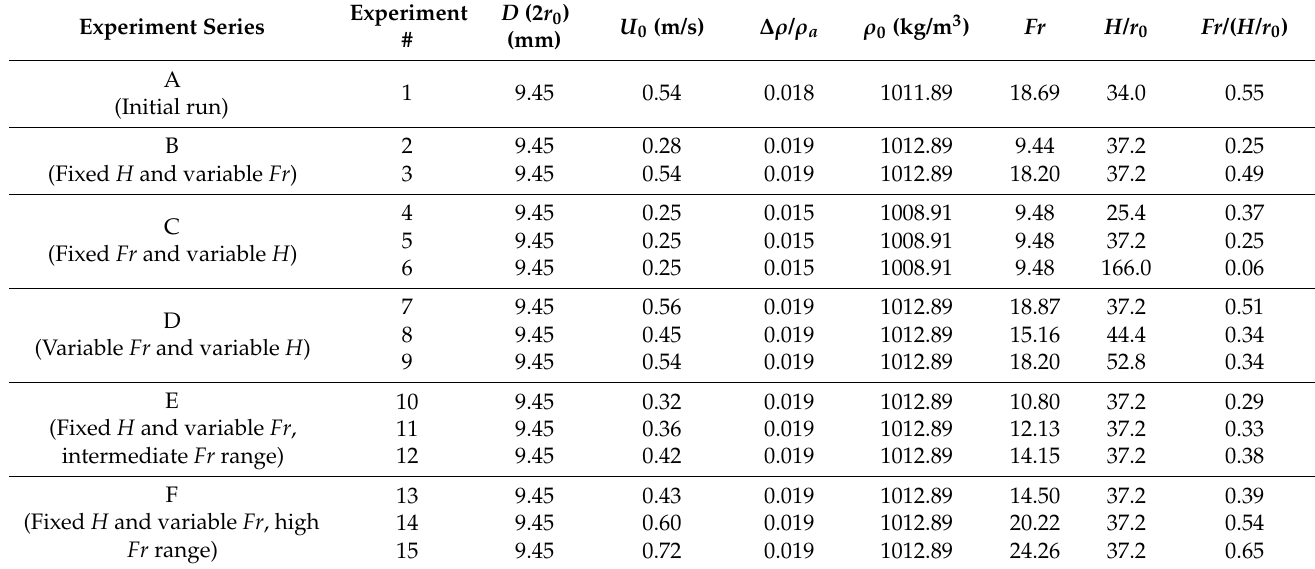
Table 3. Numerical experiment